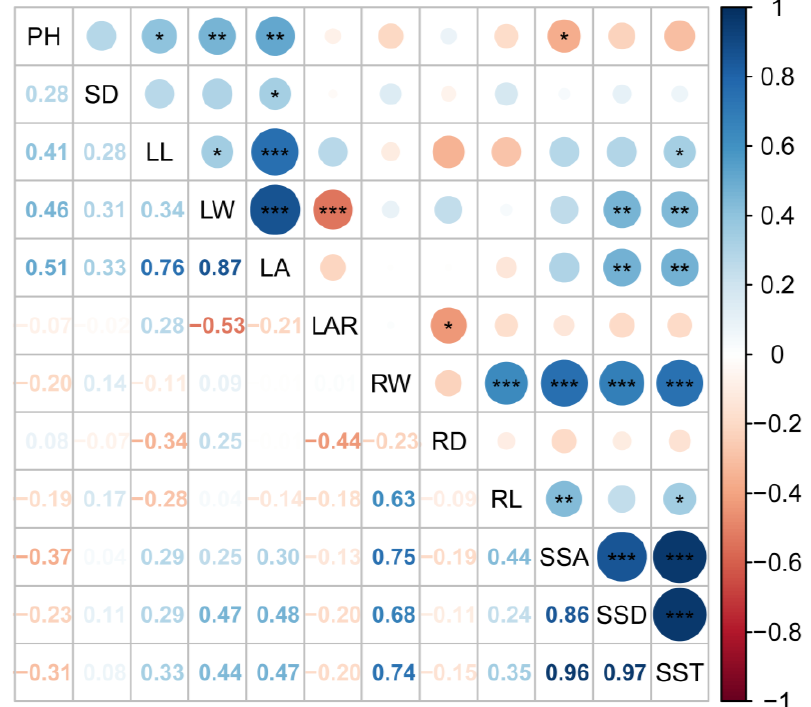
Figure 2. Correlation analysis chart of 12 traits (including major agronomic and content traits) of different germplasm of Radix bupleuri . * p < 0.05. ** p < 0.01. *** p < 0.001. The data shown in the lower left corner were significant at the level of